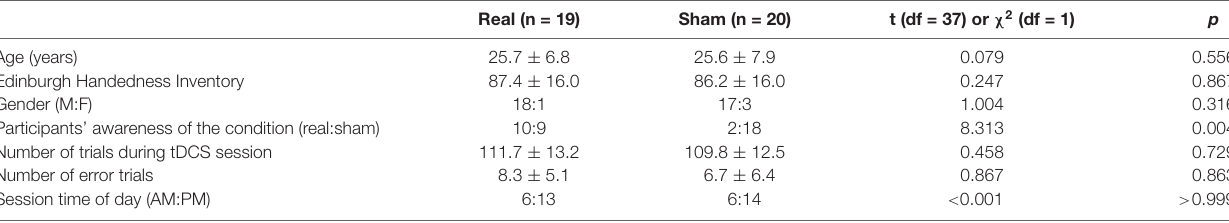
TABLE 1 | Average values of the participants’ characteristics in the real and sham tDCS groups.